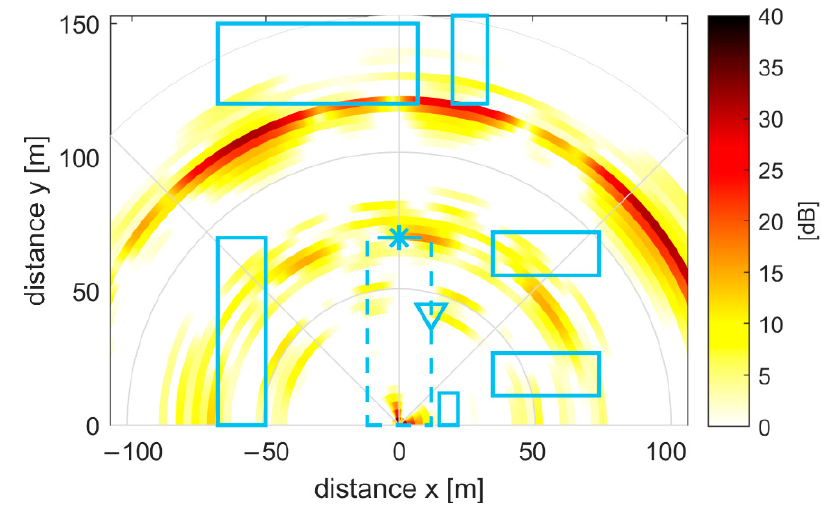
Figure 15. The scene image without calibration.